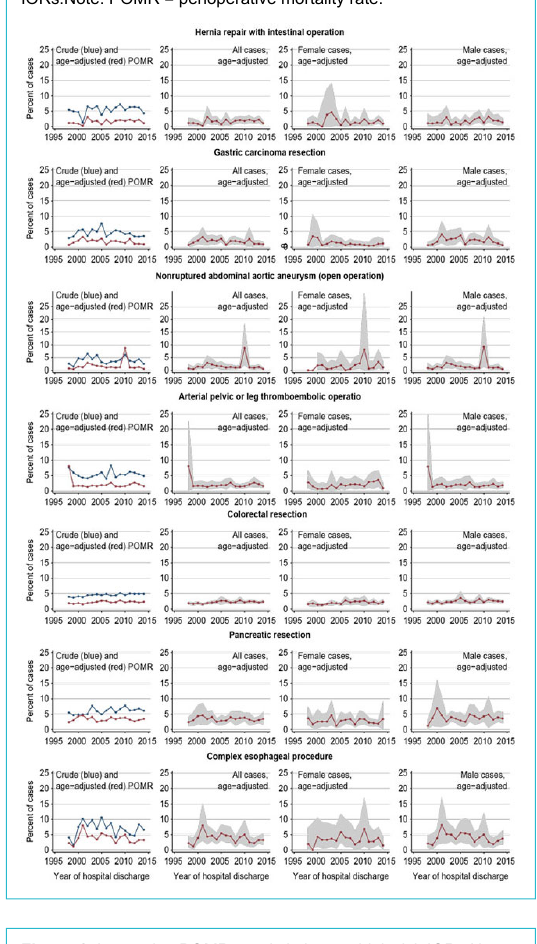
Figure 3: Unchanged POMR trends in intermediate-risk IORs.Note: POMR = perioperative mortality rate.